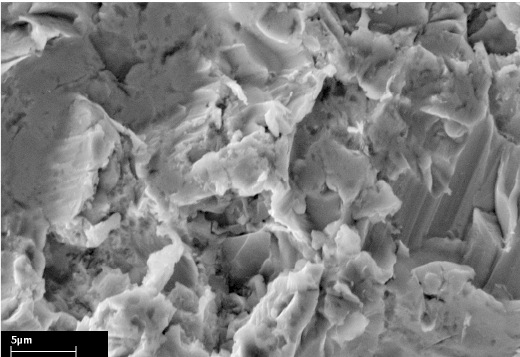
Figure 3. Scanning electron microscopy (SEM) image of the stainless steel (SS) sandblasted substrate. The same morphology is observed after film deposition.